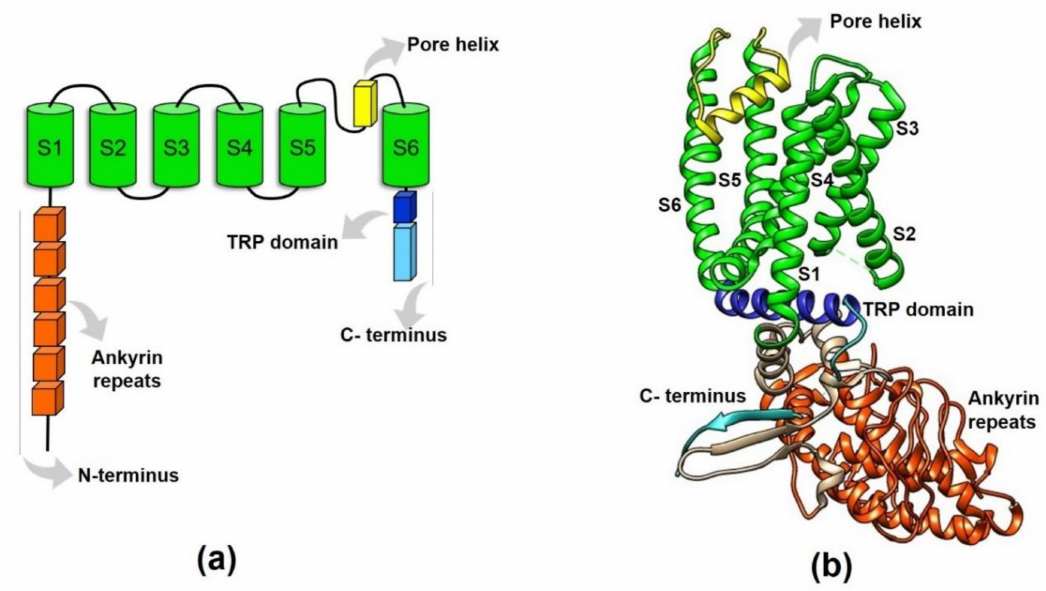
Figure 2. Structural features of the TRPV1 protein. ( a ) This figure schematizes the domains of a TRPV1 monomer (or subunit). The amino- and carboxy- termini are intracellularly located (N- and C- termini), the six ankyrin repeats and the TRP-box are contained in the N- and C-termini, respectively. The re-entrant loop between the S5–S6 forms the ionic conduction pore when the tetramer is formed. ( b ) 3D-representation of a TRPV1 subunit displaying the arrangement of the domains represented in ( a ). S1–S6: transmembrane